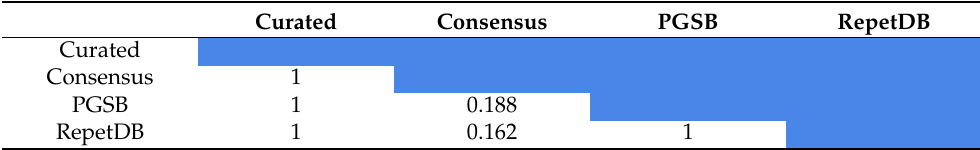
Table 2. p -values obtained using pairwise comparison through Bonferroni’s